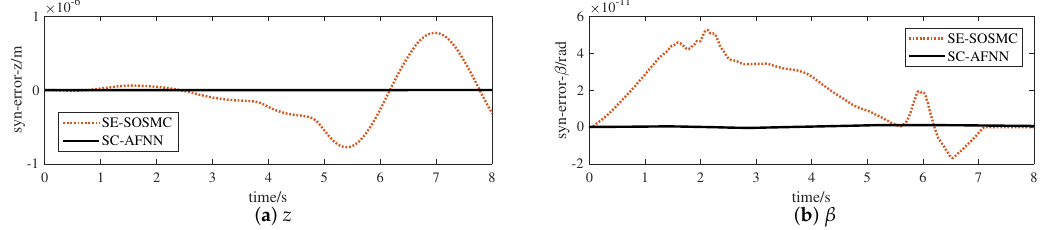
Figure 7. The synchronization error curves of each component of the UBSHR’s end-effector. ( a ) Synchronization error in z -direction; ( b ) Synchronization error of β